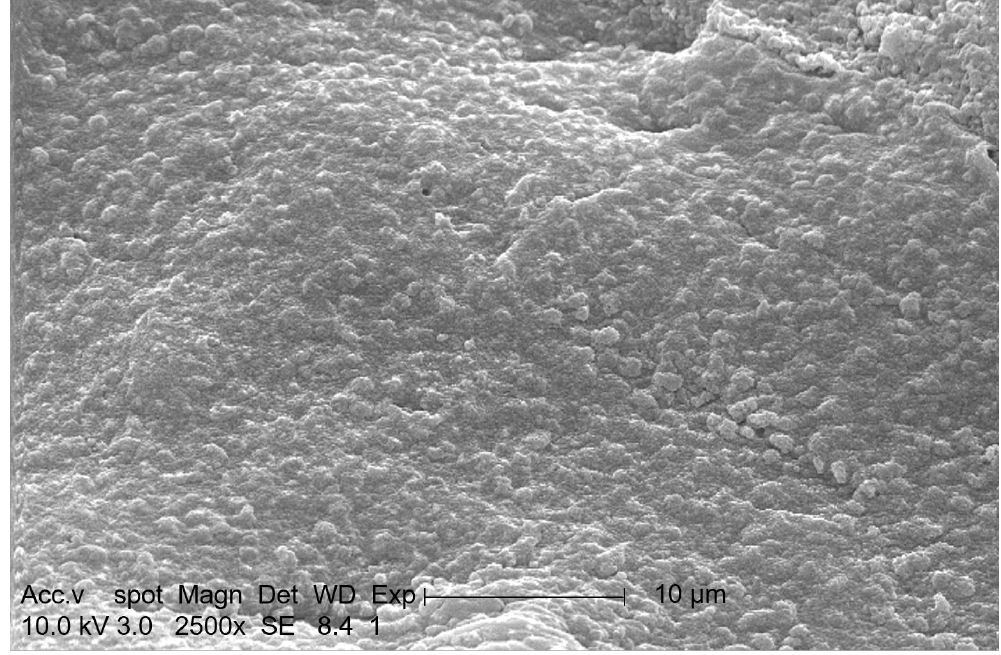
Figure 3. SEM image of the interior of the bio-microcapsules.